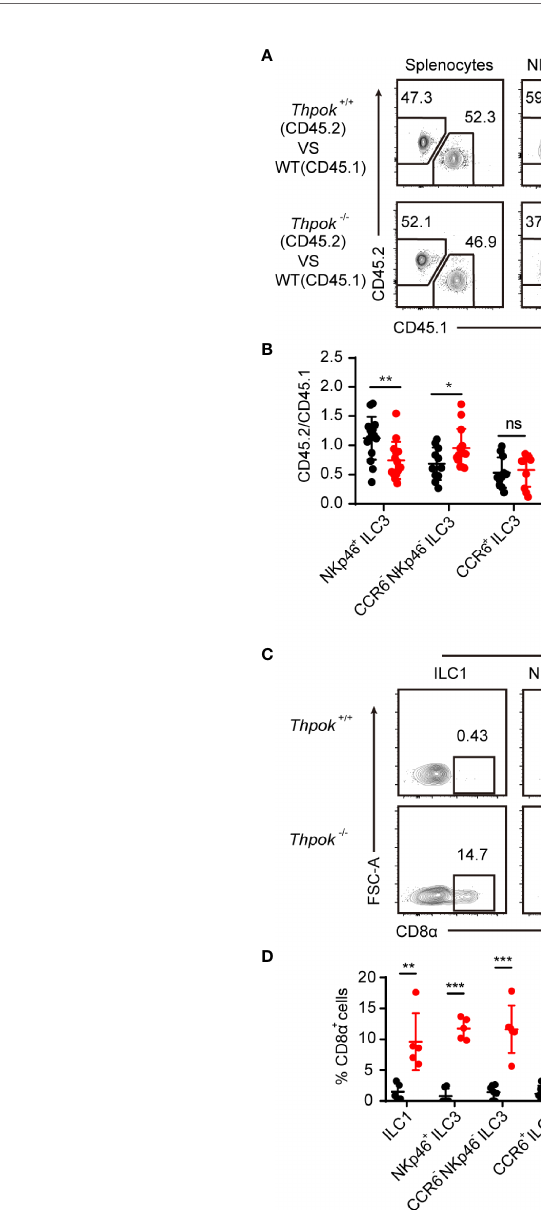
FIGURE 2 | Abnormal differentiation of ILC3s in ThPOK-de fi cient mice is cell-intrinsic. (A – D) 2 × 10 6 ThPOK-de fi cient or WT BM cells were co-transplanted with 2 × 10 6 CD45.1 BM cells into lethally irradiated CD45.1 recipient mice. Examine donor chimerism of the indicated ILC3 subpopulations in small intestine 8 weeks later through fl ow cytometry. (A) Flow cytometric analysis of CD45.1 and CD45.2 expression in the indicated ILC3 subsets isolated from the siLP of reconstituted mice. Plots were gated on total splenocytes (left) and ILC3 subsets (right) respectively. (B) The percentages of donor derived cells in the indicated ILC3 subsets (CD45.2/ CD45.1) were compared. The number of ThPOK donor derived cells (CD45.2 + ) in the indicated ILC3 subsets were shown on the right. (mean ± SEM; n = 8-13; * P < 0.05, ** P < 0.01, Student ’ s t test). (C) Plots of CD8 a expression in the indicated CD45.2 + cells were gated on total ILC1 (left) and ILC3 subsets (right) respectively. (D) Percentages and numbers of CD8 a + cells in the indicated cells were calculated. (mean ± SEM; n = 5-7; ** P < 0.01, *** P < 0.001, Student ’ s t test). Data are representative of at least three independent experiments. ns, no signi fi cant